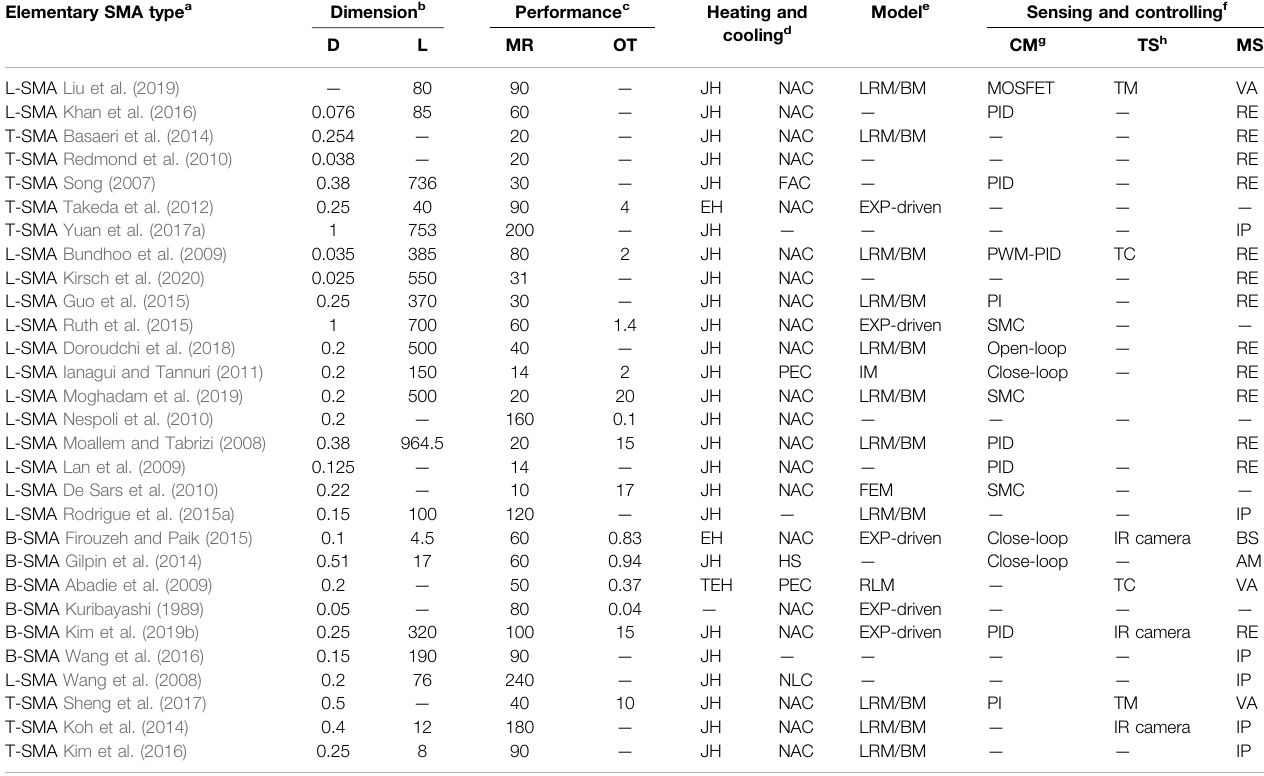
TABLE 2 | Summary of existing SMA-based actuation system for BRM. Elementary SMA type a